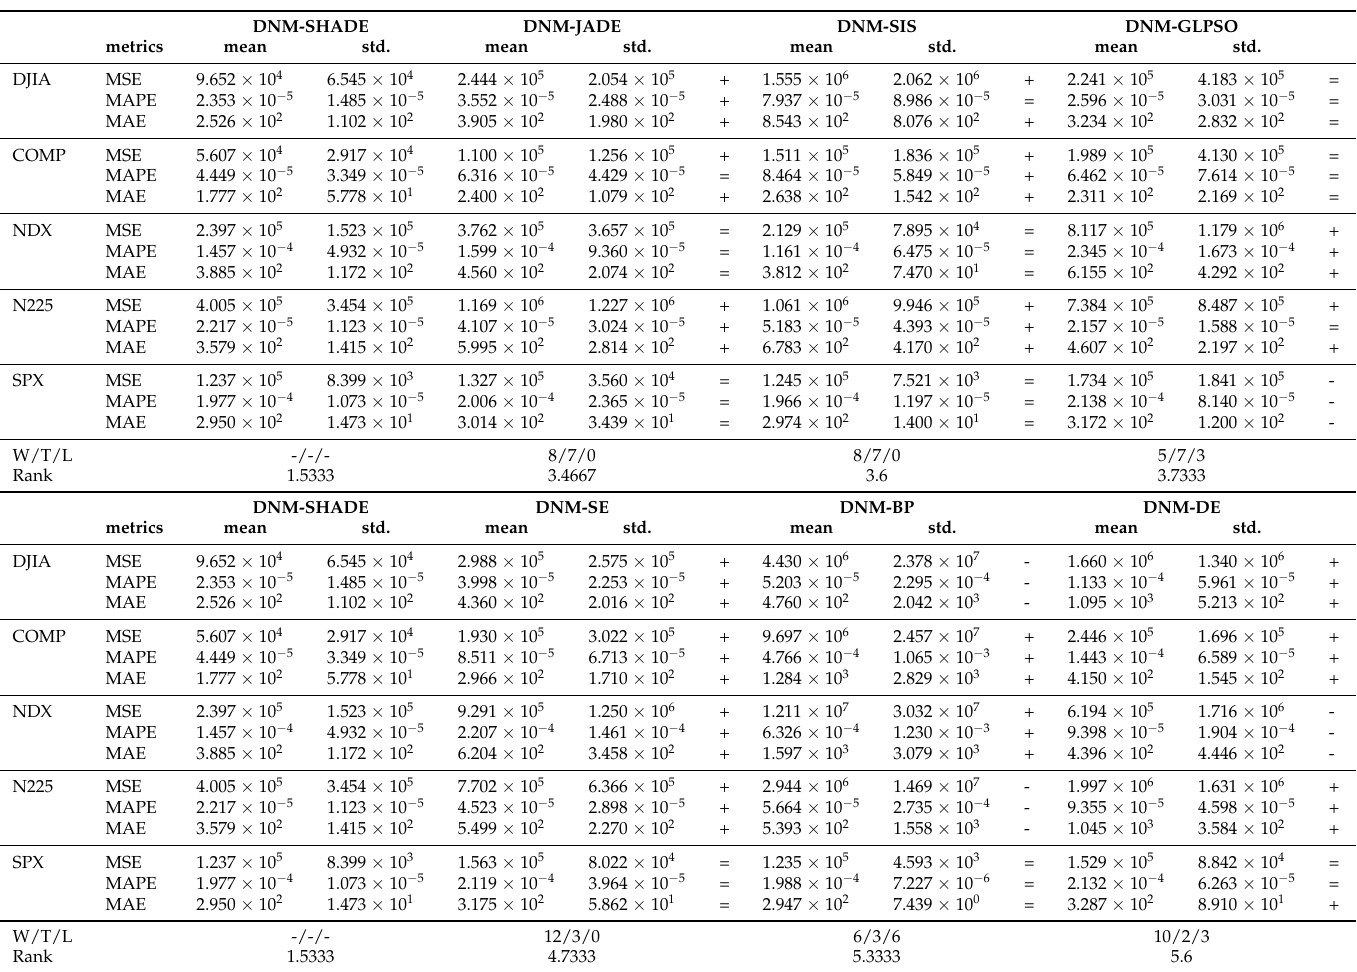
Table 4. Performance of DNMs trained by MHAs on the FTSF problem.